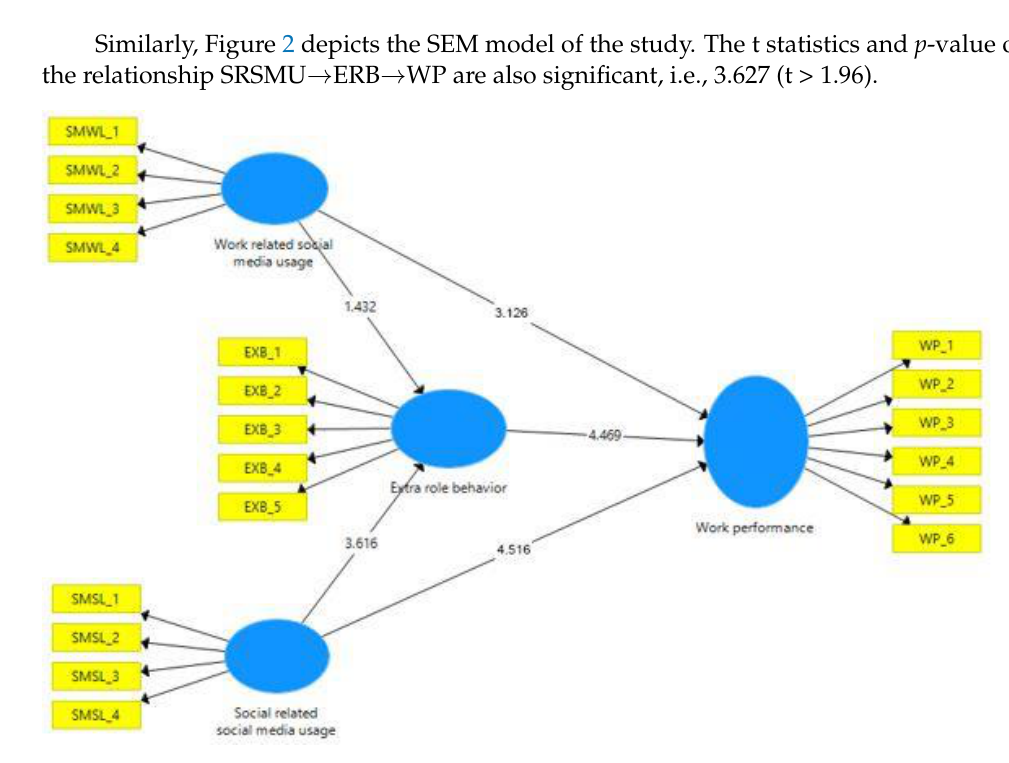
Figure 2. SEM model of the study